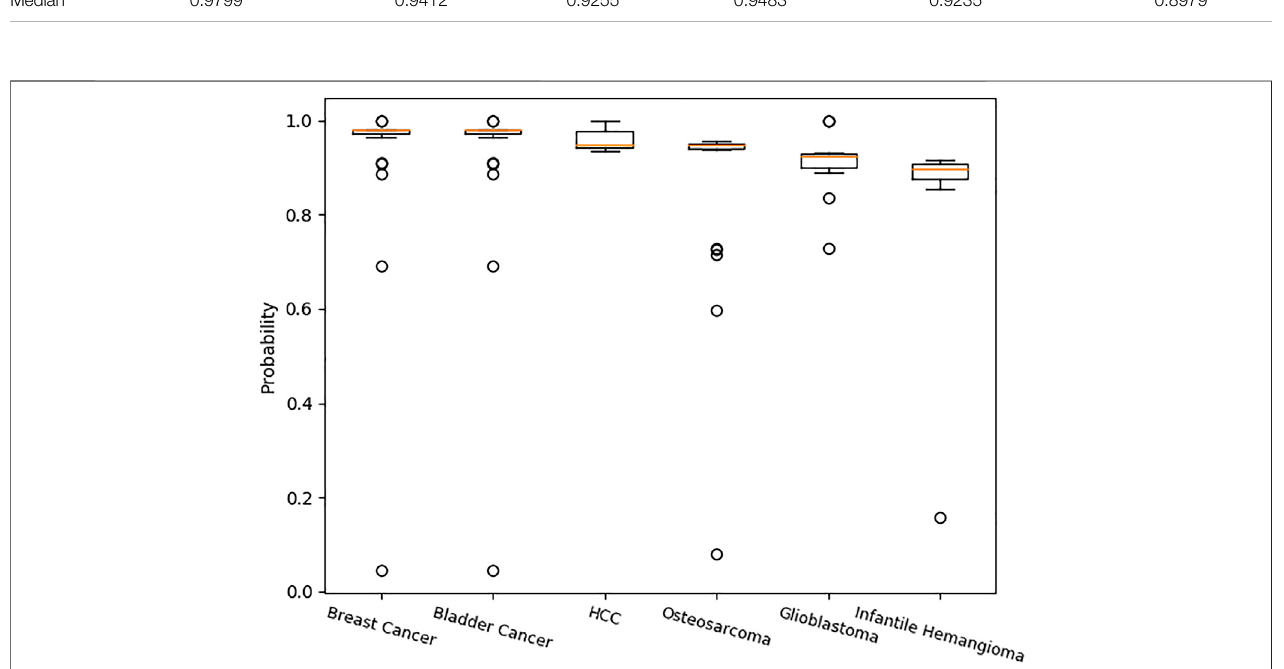
FIGURE6| Probabilitydistributionofspeci fi cassociationsinCircR2DiseasepredictedbySAAED. Figure6 clearlyshowsthatmostprobabilitydataaredistributed between 0.92 and 1 (except for infantile hemangioma, the median probability distribution is 0.8979), which indicates that SAAED can effectively identify most associations in CircR2Disease. The more the data are, the closer the predicted probability is to 1.